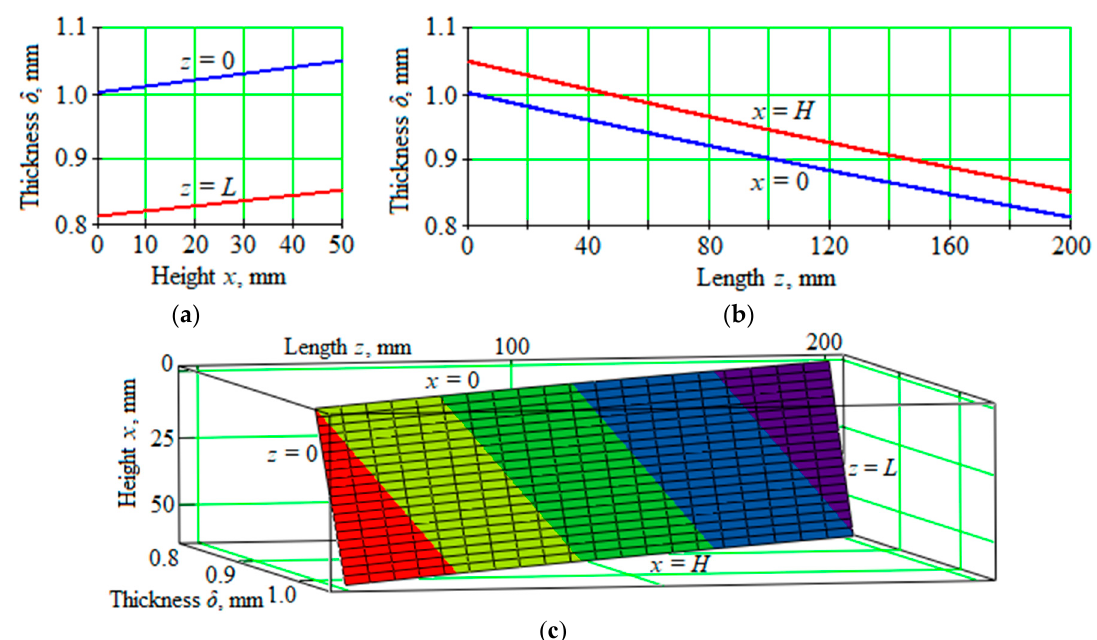
Figure 2. Components of the average film flow velocity: ( a )— u ( x , 0) and δ ( x , L ); ( b )— δ (0, z ) and δ ( H , z ); ( c )—3D graph of the film thickness function.